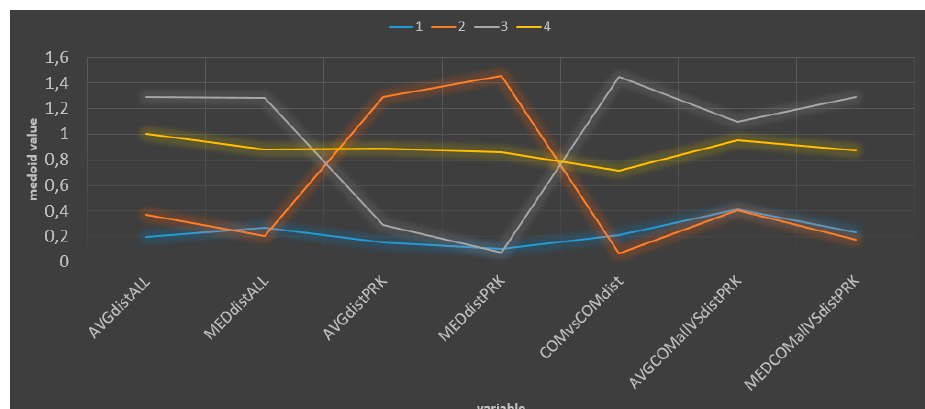
Figure 9. Medoid values of user clusters.